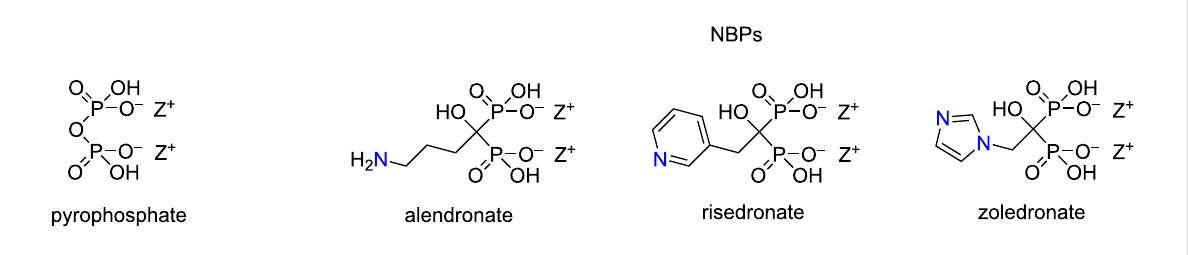
Figure 1: Structure of natural pyrophosphate and examples of NBPs (Z = Na or H).